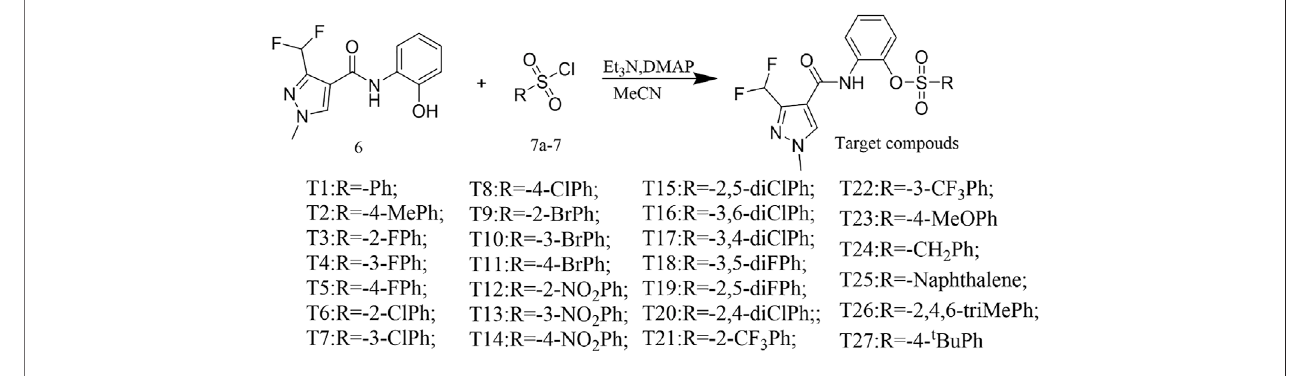
SCHEME 3 | Synthesis of the target compounds.